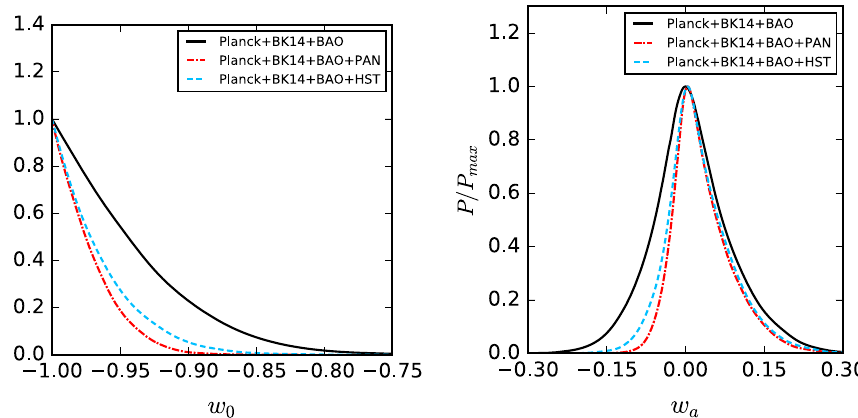
Fig. 4 Comparison of 1-D marginalized posterior distributions for w 0 and w a for different data combinations in NPDDE11+ r